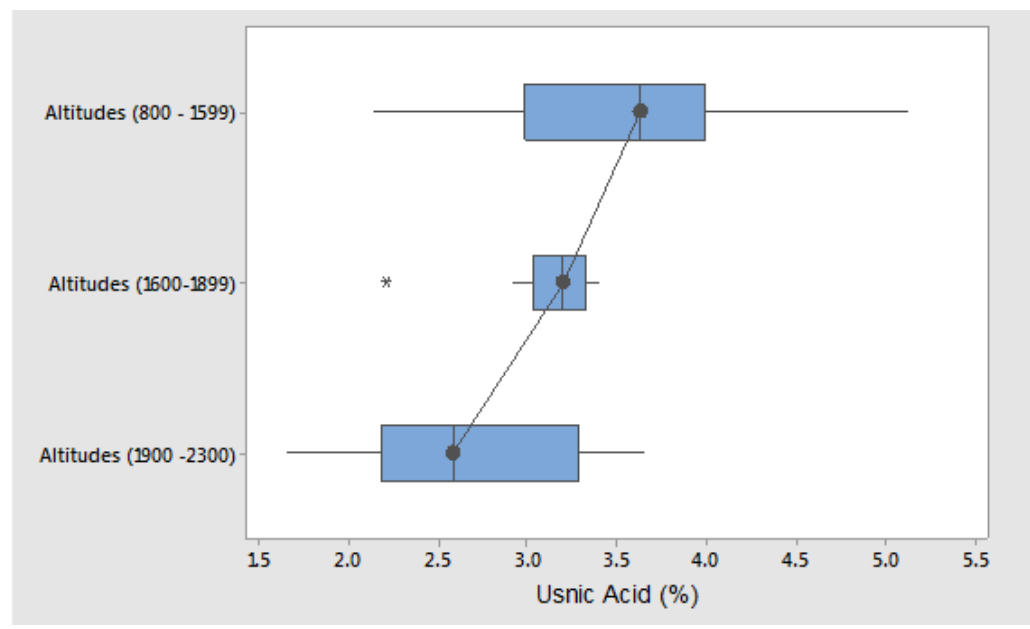
Figure 4. Usnic acid concentration at the six sites in Kaski. The sites are sorted in three groups according to altitude.